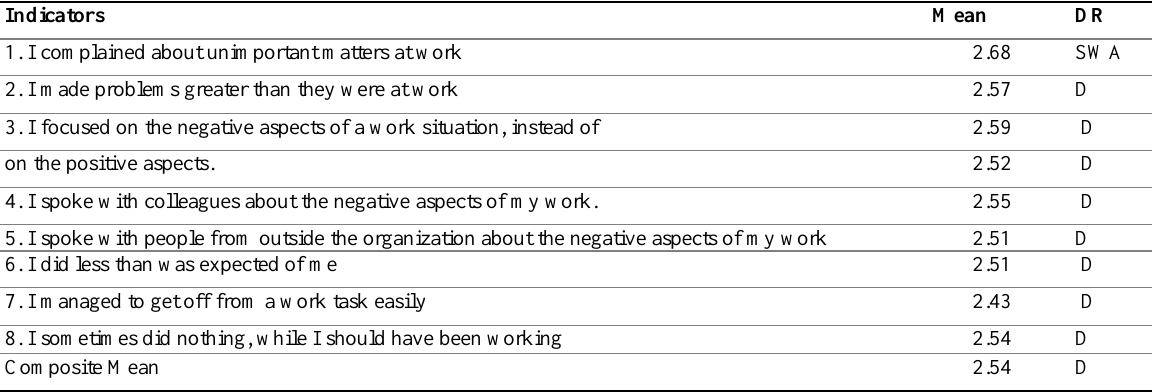
Table 9: Individual Work Performance of Employees in terms of Counterproductive Behaviour Indicators